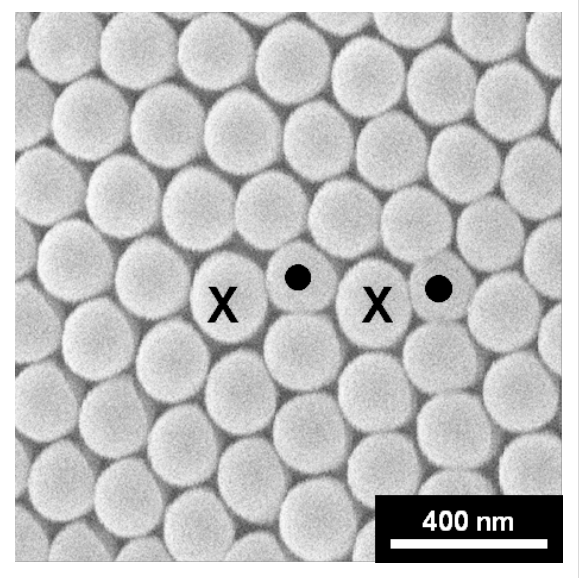
Figure 2: Triple junction in the facet structure and nanonipples in three adjacent facets (magnification: 6,000×).